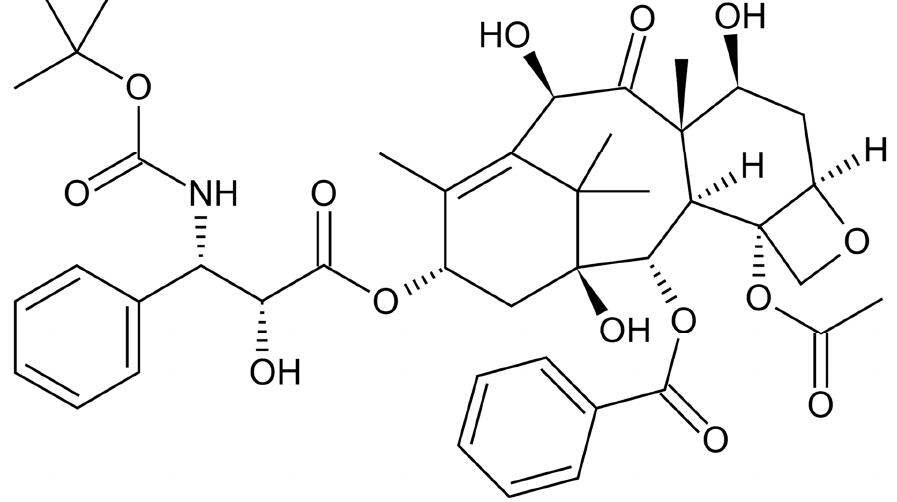
Figure 3. Chemical structure of docetaxel (Dtx).